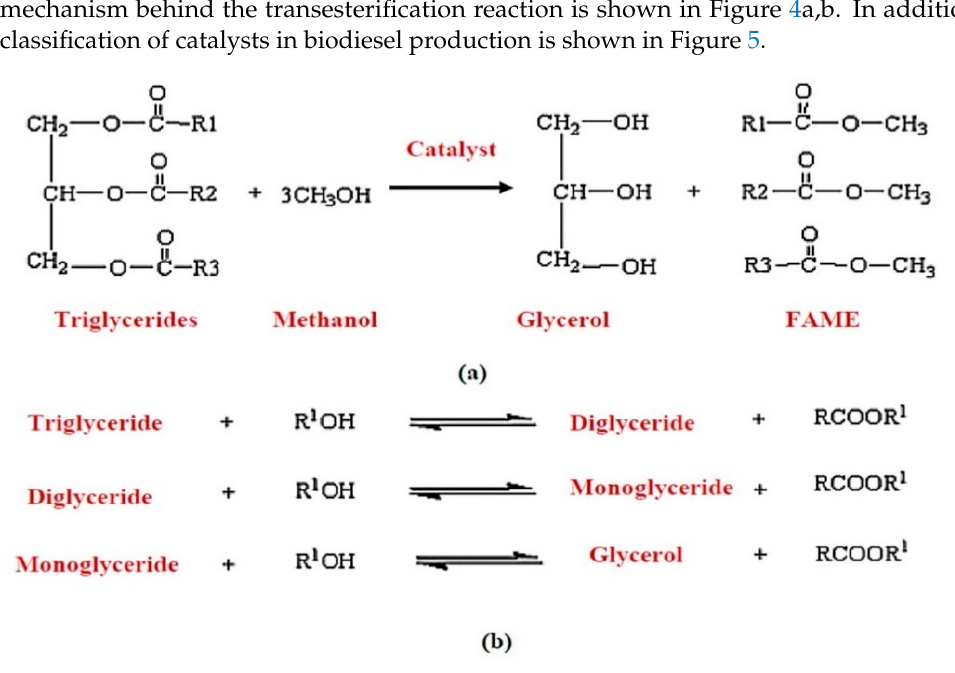
Table 3. Different researchers work on heterogeneous catalysts.